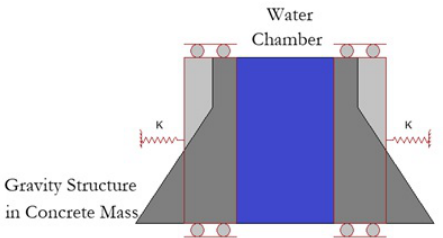
Figure 1. 2D double piston-acoustic cavity system superimposed on the supposed rigid-mobile lock-tank system